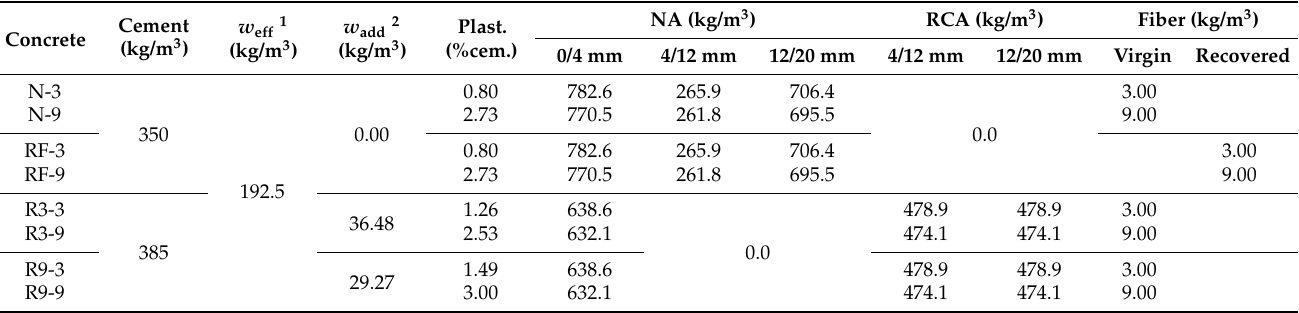
Table 2. Mix design of the tested